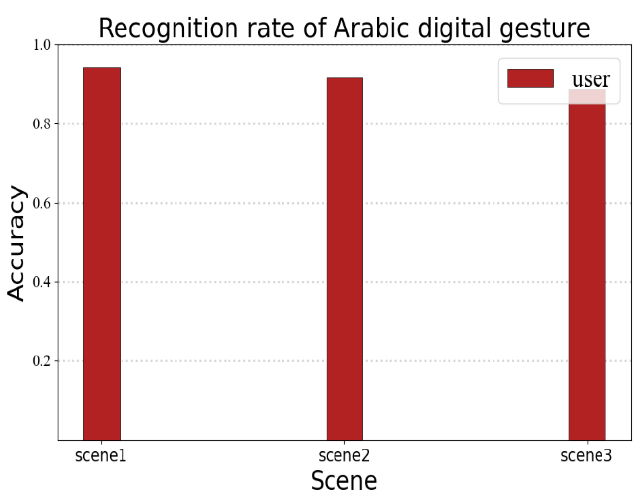
Figure 17. Accuracy in different environments.